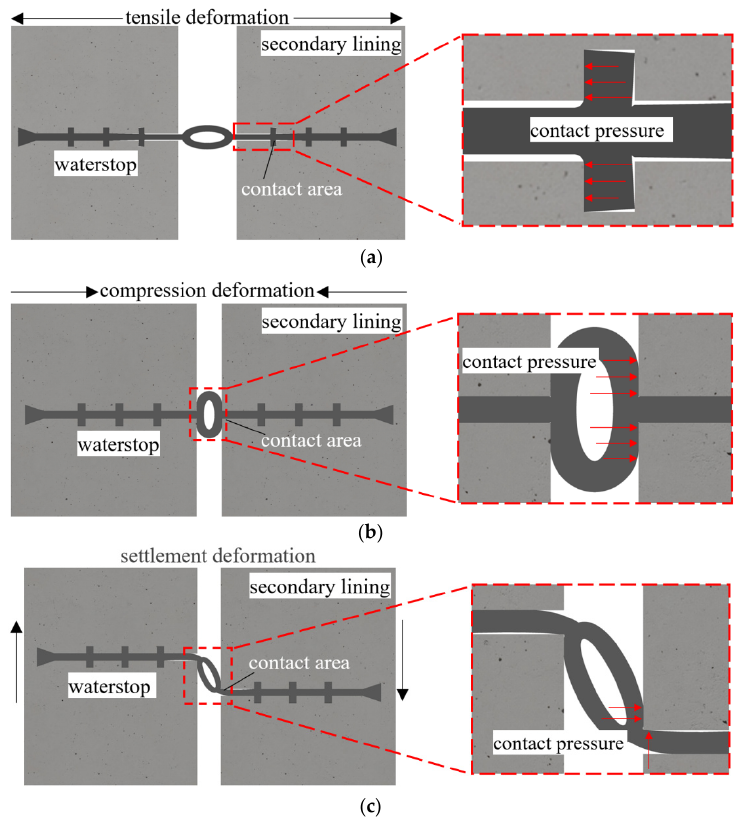
Figure 4. The deformation contact pressure of the waterstop. ( a ) Tensile contact pressure. ( b ) Com- pressive contact pressure. ( c ) Settling contact pressure.